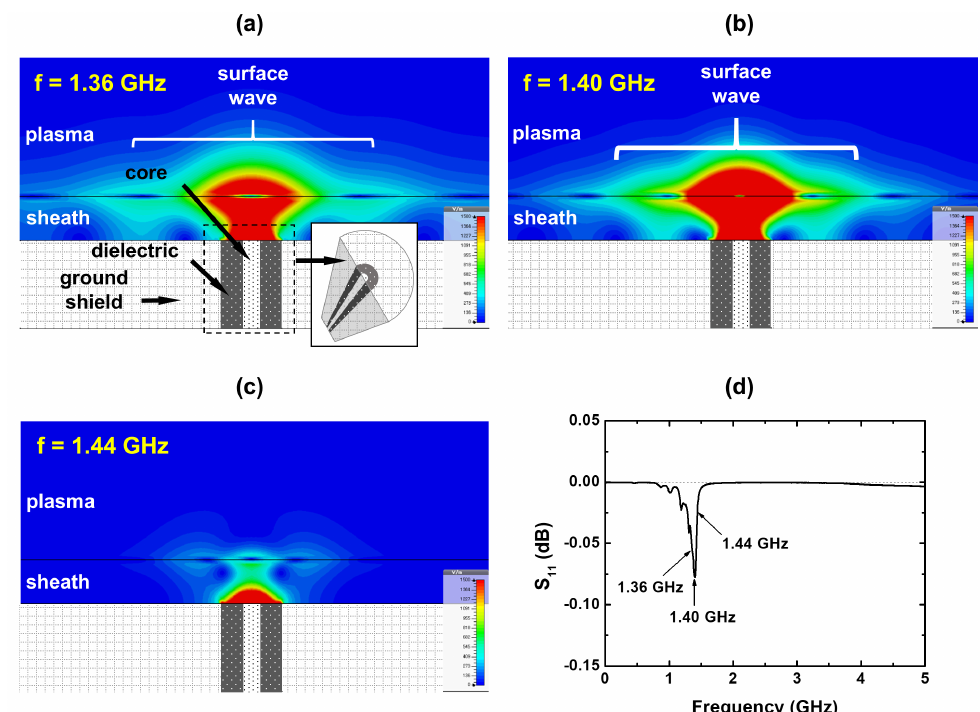
Figure 2. Magnitude of the absolute electric field ( E 2 = E 2 x + E 2 y + E 2 z ) at different frequencies: ( a ) 1.36 GHz, ( b ) 1.40 GHz, and ( c ) 1.44 GHz, and ( d ) S 11 spectrum The electron density is 5 × 10 10 cm − 3 , pressure 100 mTorr, and sheath width 5.0 mm. Here, the resonance frequency is 1.40